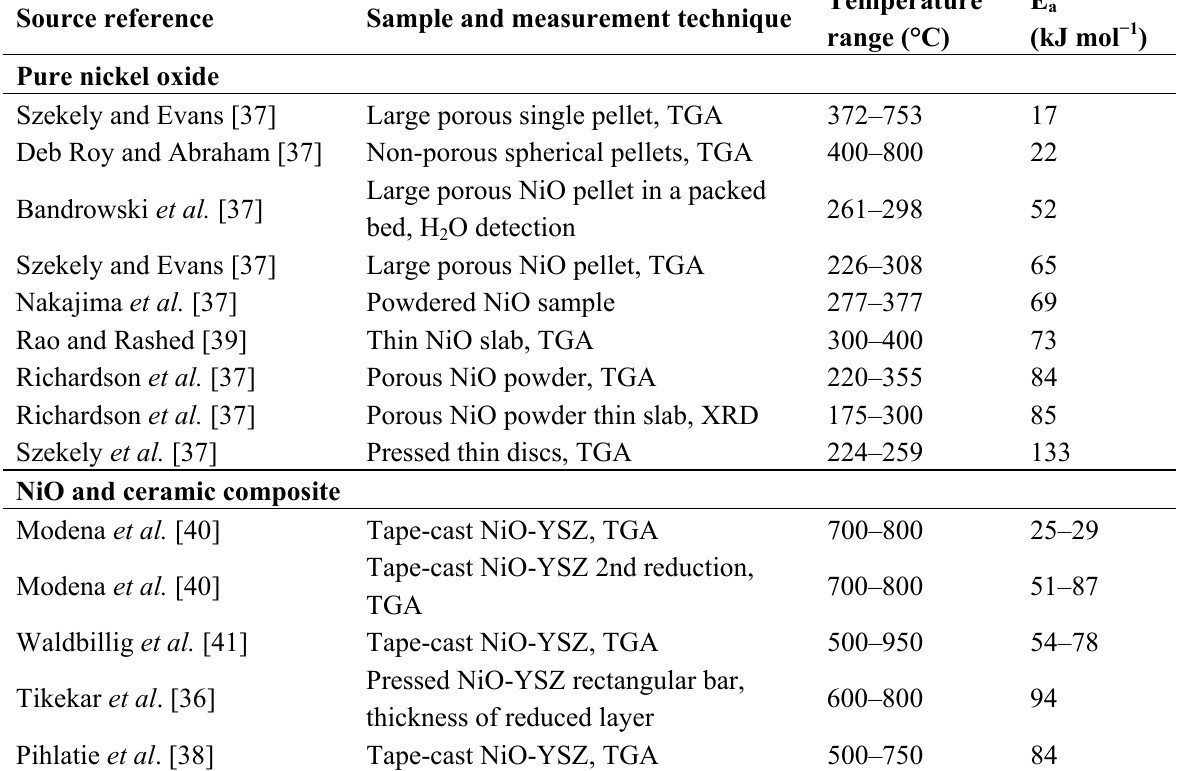
from Richardson et al. [37] and other 2